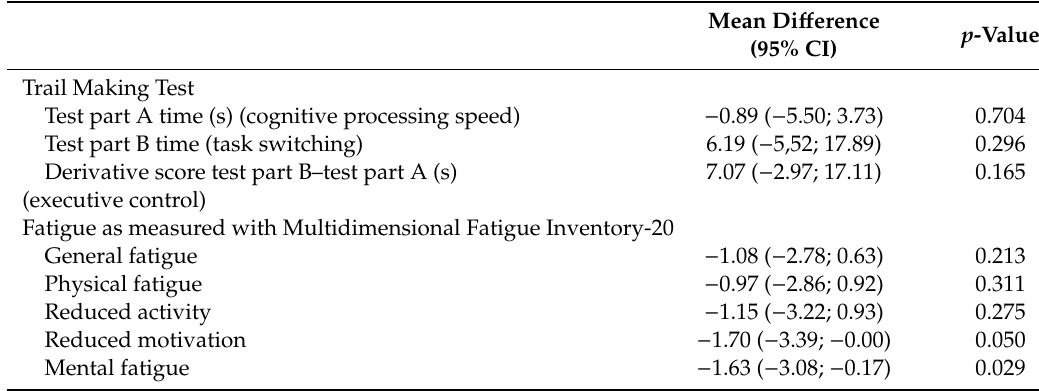
Table 2. Comparison of cognitive functioning and fatigue levels in patient groups with and without obsessive compulsive personality disorder (OCPD)